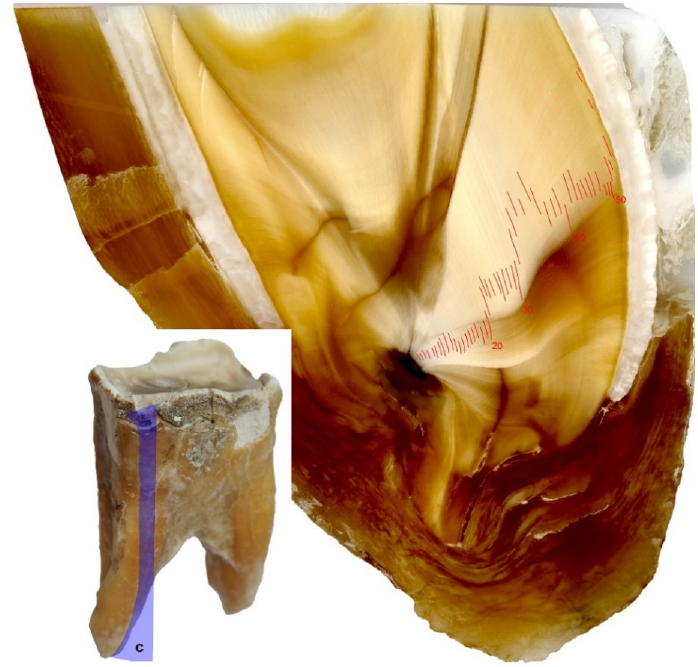
Figure 9. Dentine growth lines on longitudinal section, on the third premolar (P 3 ) of the white rhi- noceros female, c : longitudinal section.